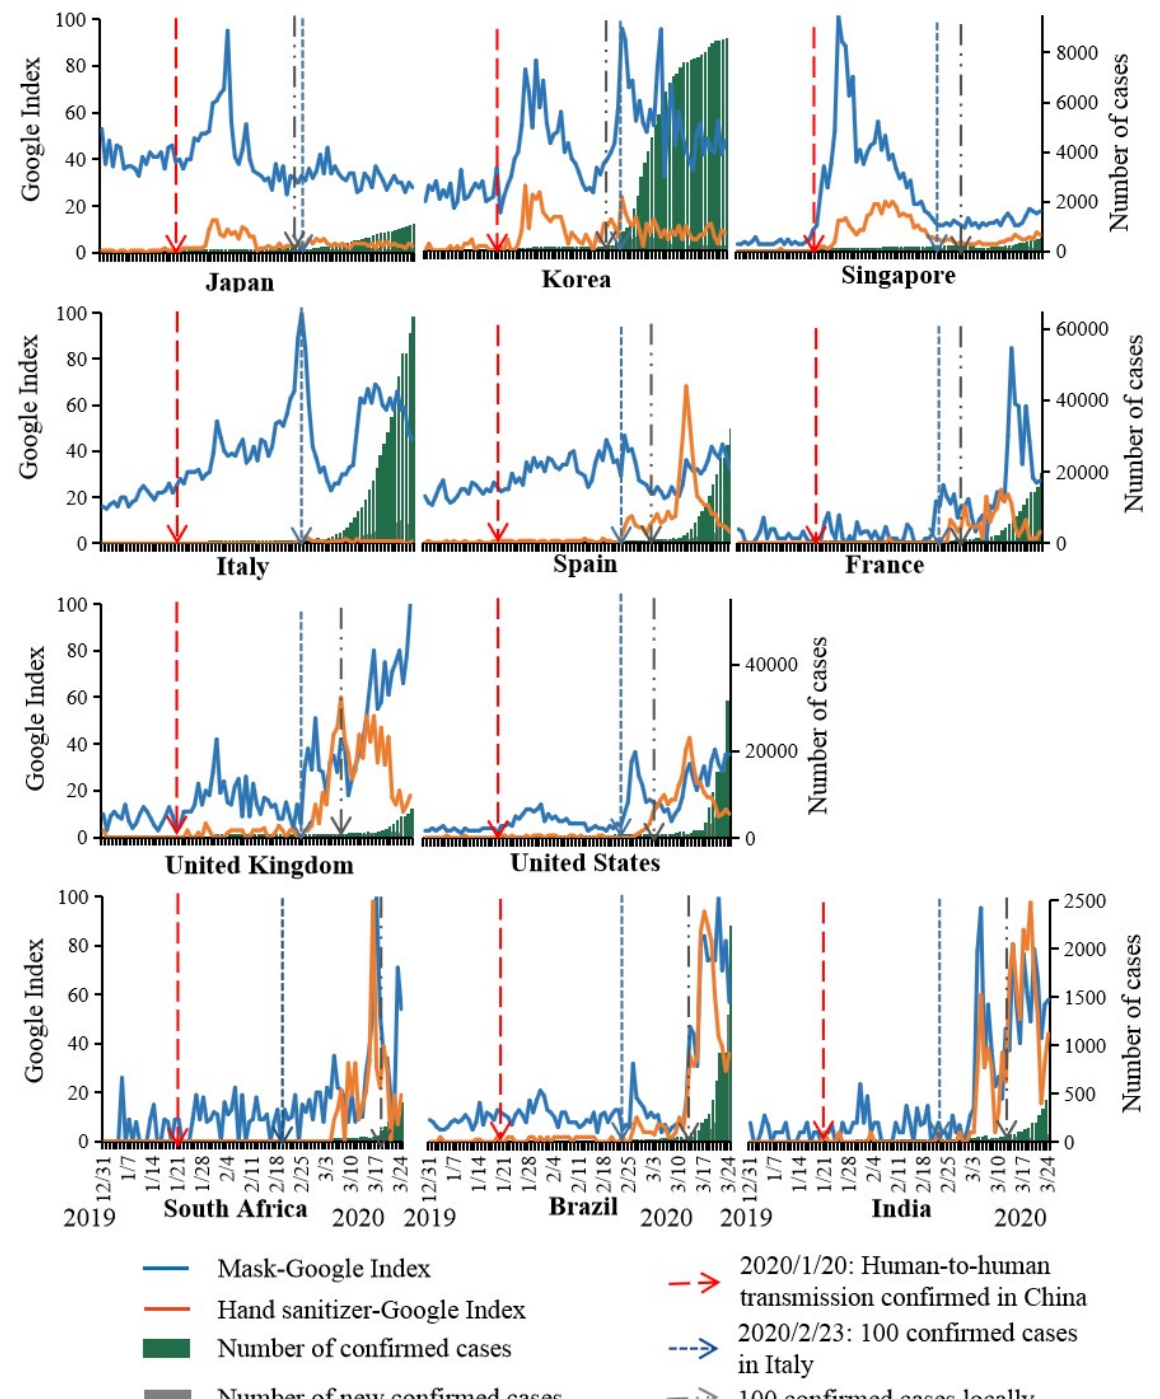
Figure 3. Cross-country comparison of Google Trends data for mask and hand sanitizer with numbers of COVID-19 cases from December 2019